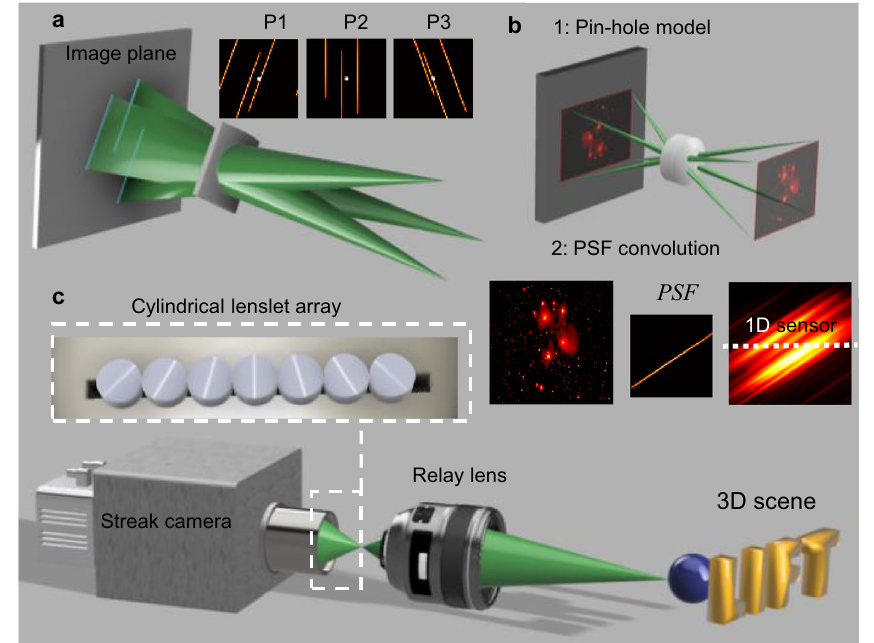
Fig. 1 Working principle and implementation of light fi eld tomography. a Illustration of image formation by a cylindrical lens. Three point sources in the object space are transformed into parallel lines on the image plane, producing a projection image. Acquiring such projection images from different perspectives using lenslets oriented at different angles naturally samples the light fi eld of the 3D scene, as exempli fi ed in the insets P1 – P3, where the image center is highlighted to visualize the disparities. b Two-step modeling of cylindrical lenslet imaging process. For clarity, an image showing predominantly point-like structures is rendered. The 1D projection data is obtained by sampling the convolution result of the pinhole image and line-shaped PSF. Recording such 1D data over time yields a time-resolved measurement. c Typical system setup of a LIFT camera. The cylindrical lenslet array is closely secured to the entrance slit of the streak The ultrafast LIFT system con fi guration is diagrammed in Fig. 1c. Seven customized cylindrical lenslets (diameter, 2 mm; focal length, 8 mm) oriented at distinct angles are assembled on a 3D printed holder and aligned with the slit of a streak camera. The lenslet arrangement — the sequence of the invariant axis ’ angles with respect to the slit — can be optimized for different applications, such as an automatically extended depth of fi eld (Supplementary Note 3.3). The 3D scene is imaged by a camera lens to the intermediate image space, from which the cylindrical lenslet array forms differently projected sub-images onto the slit plane. A fi eld stop at the intermediate image plane reduces the fi eld of view to avoid the sub-image overlap between the adjacent lenslets. The streak camera relays the 1D projection images from the slit onto a photocathode, converts it to the electronic domain, and eventually de fl ects it onto different rows of a CCD camera according to the photons ’ time of arrival. Because the temporal axis is orthogonal to the 1D projection image, there is no spatial- temporal coupling in LIFT, leading to an optimal temporal resolution.